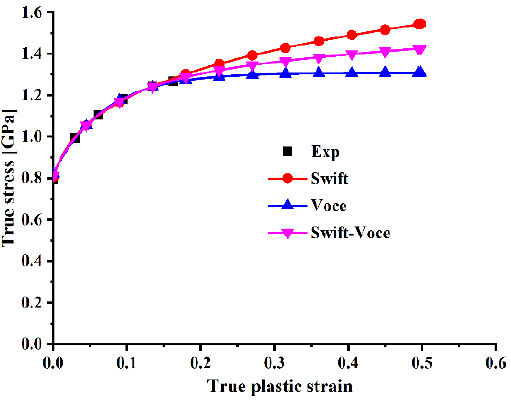
Figure 4. Stress-strain curves of the dog-bone specimens along the rolling direction. Table 3. The parameters of the Swift-Voce model for QP980.